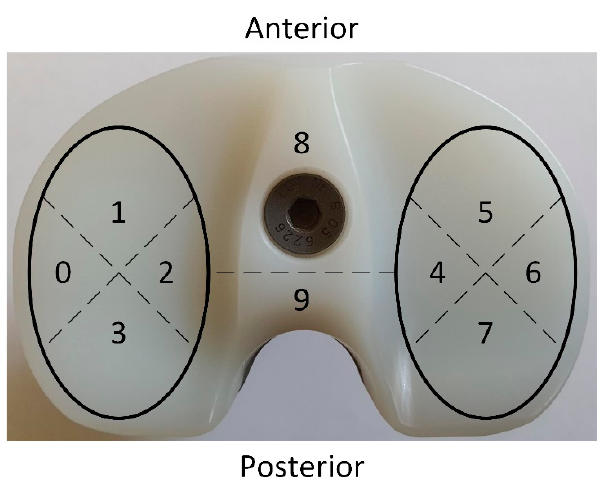
Figure 2. The partition system proposed by Hood et al. [64] for the quantification of deterioration modes in the case of UHMWPE tibial insert of knee prostheses.